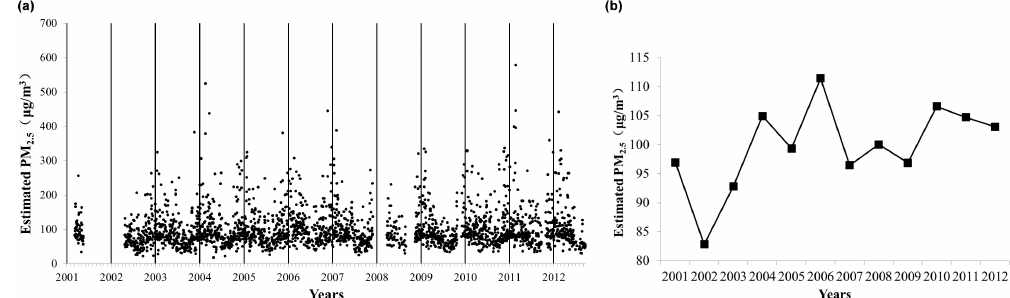
Figure 4. Estimated PM 2 . 5 from 2001 to 2012 in Beijing using AERONET AOD with BLH and RH correction: (a) daily PM 2 . 5 and (b) yearly averaged PM 2 . 5